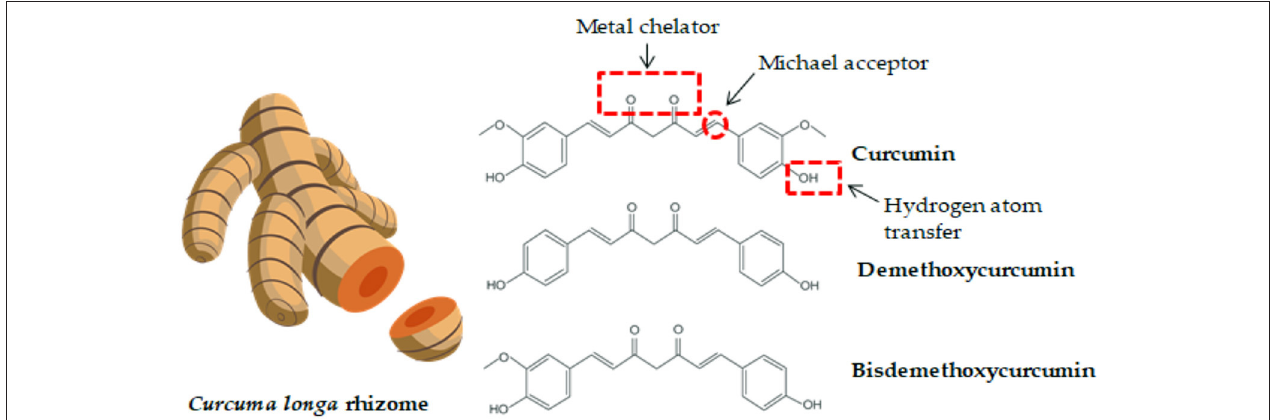
FIGURE 1 | Curcuma longa rhizome and the chemical structure of curcumin and its derivatives. Functional groups in curcumin components which contribute to its activity and bioavailability are highlighted ( 24,